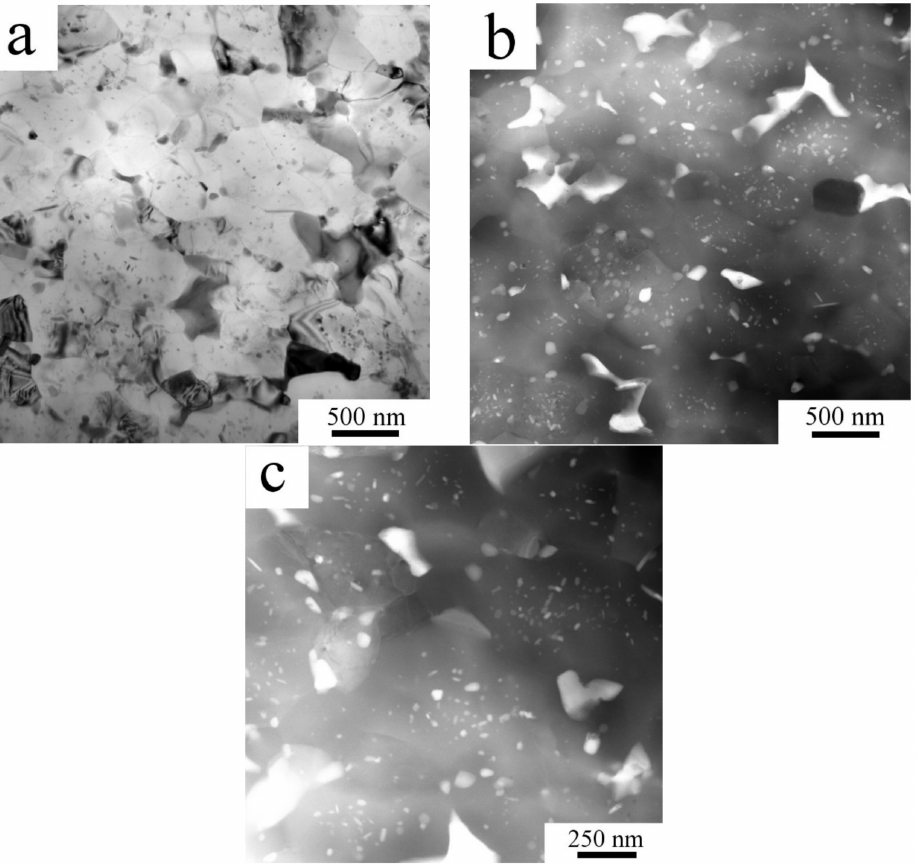
Figure 11. The microstructure of the Al7075_MC compact: ( a ) grain structure, STEM-BF; ( b ) particles; ( c ) detail of particles,